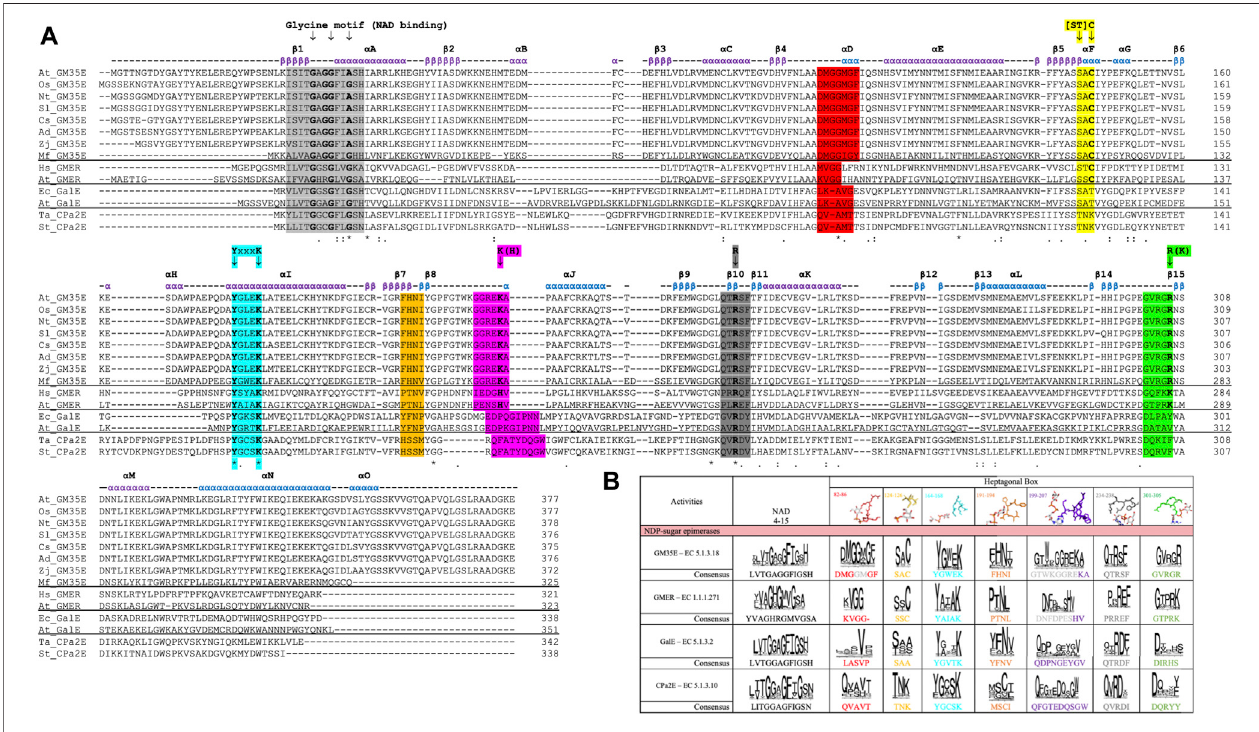
FIGURE 3 | (A) Multiple Sequence Alignment (MSA) of several studied GM35E (At, Arabidopsis thaliana ; Os, Oryza sativa ; Nt, Nicotiana tabacum ; Sl, Solanum lycopersicum ;Cs, Citrussinensis ;Ad, Actinidiadeliciosa ;Zj, Ziziphusjujuba ;Mf, Methylacidiphilumfumariolicum strainSolV)and2representativesoftherelatedNS-SDR activities GMER, GalE and CPa2E (At, Arabidopsis thaliana ; Hs, Homo sapiens ; Ec, Eschericia coli ; Ta, Thermodesulfatator atlanticus ; St, Salmonella typhi ), with highlightingoftheGlycinemotifs forNAD(P) + binding(lightgrey),heptagonalboxmotifs(incorrespondingcolors)andimportantresidues(arrows). Theabovegiven α -helices, β -strands and their numbering are from the Arabidopsis thaliana GM35E ( At _GM35E). (B) Heptagonal box model of GM35E, GMER, GalE and CPa2E. The numbering of the motifs are derived from Ta CPa2E since this fi gure is adapted from Da Costa et al. (Da Costa et al.,